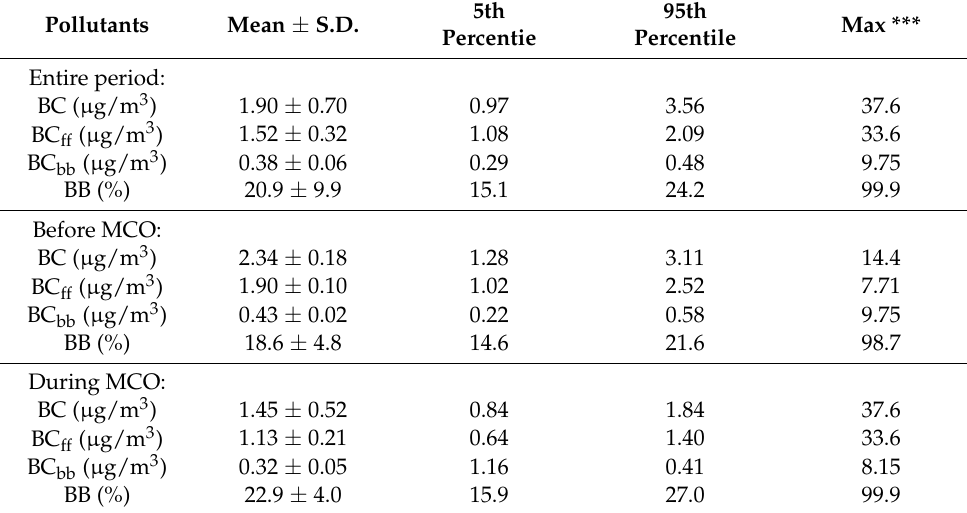
Table 1. Summary of the mean ( ± standard deviation), 5th and 95th percentiles, and maximum (max) concentrations of 1-min BC (i.e., total BC), BC ff (fossil-fuel BC) and BC bb , (biomass burning BC), and of percentage biomass burning (BB%), between 1 January 2020 and 31 May 2020 (150 days, 216,000 min). Summary data are also subdivided into measurements before the Movement Control Order (MCO) and during the MCO that was imposed on 18 March